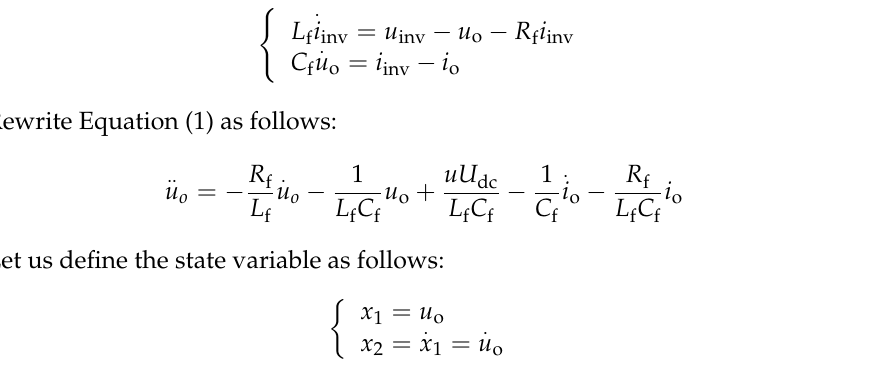
U dc is the DC voltage u and L C f , f , and / Z L NL